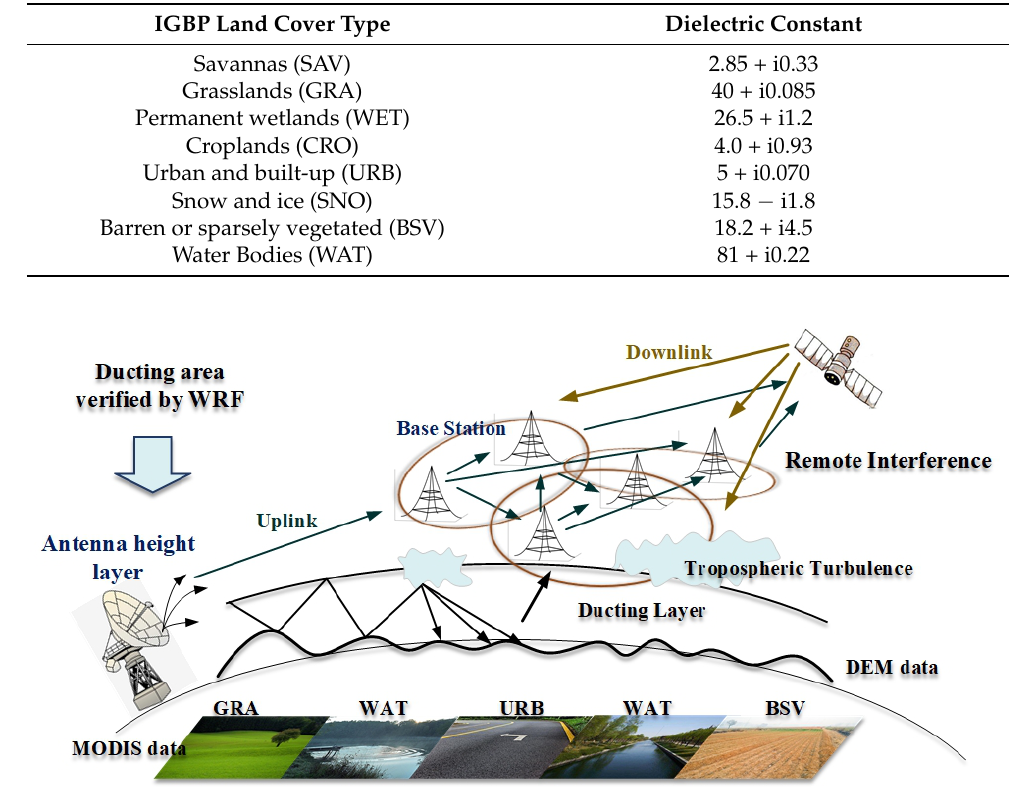
Figure 12. Schematic diagram of over-the-horizon forward-propagation of intercity links based on multi-source data